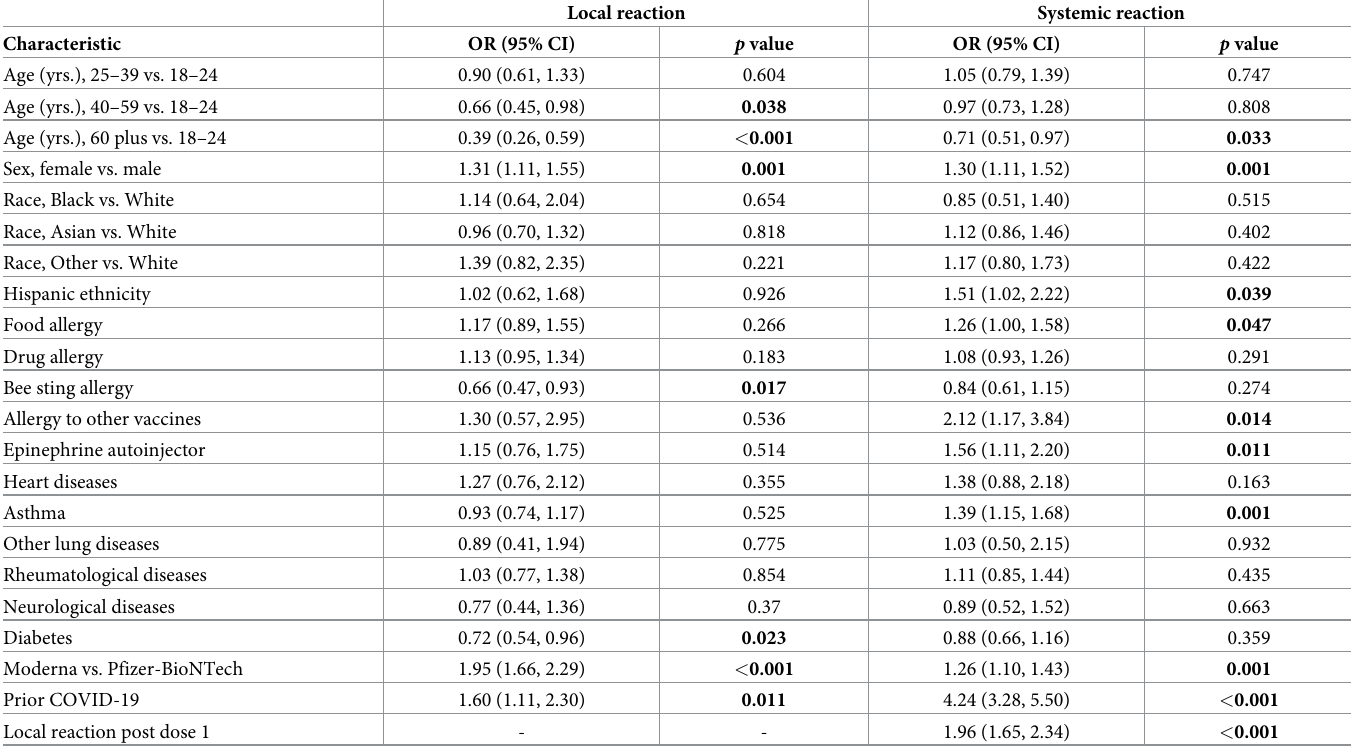
Table 2. Factors associated with local and systemic reactions after the first COVID-19 vaccine dose.